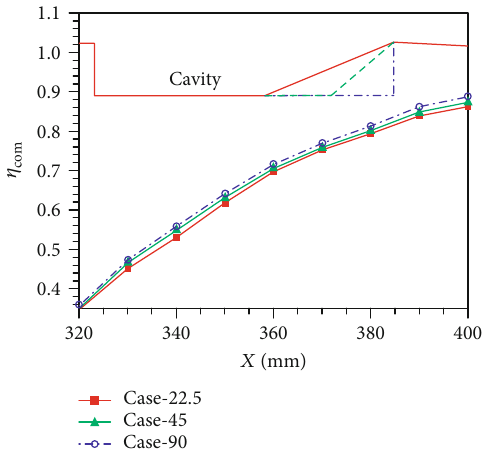
Figure 15: Variation of fuel combustion e ffi ciency around the cavity for all cases.